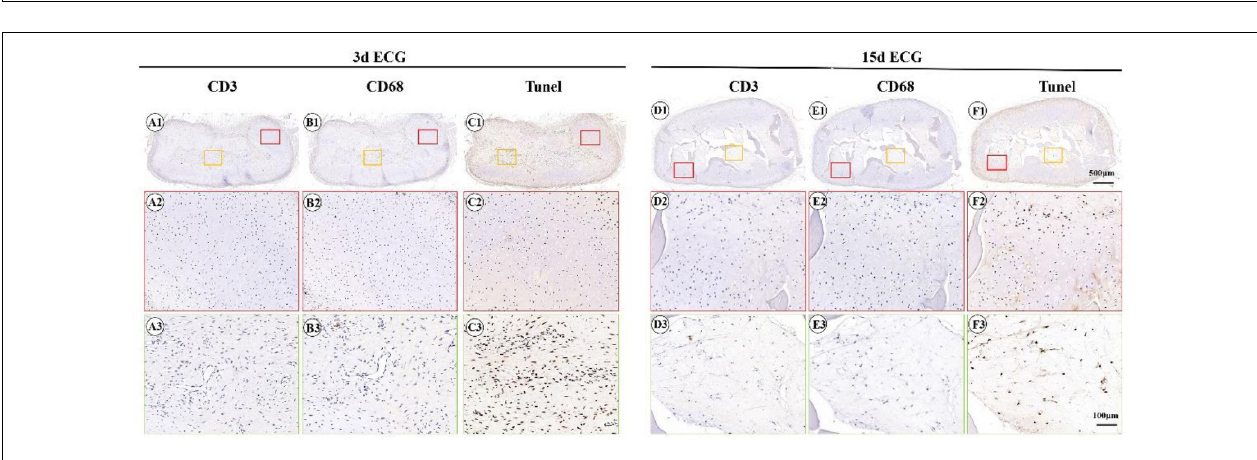
FIGURE 6 | Inflammatory reactions characterized by CD3, CD68, and terminal deoxynucleotidyl transferase biotin dUTP nick end labeling assay (TUNEL) staining. CD3 staining of 3 d engineered cartilage gel–decalcified bone matrix (ECG–DBM) (A1–A3) and 15 d ECG–DBM constructs (D1–D3) after 12 weeks in vivo in autologous goat. CD68 staining of 3 d ECG–DBM (B1–B3) and 15 d ECG–DBM (E1–E3) constructs after 12 weeks in vivo in autologous goat. TUNEL staining of 3 d ECG–DBM (C1–C3) and 15 d ECG–DBM (F1–F3) constructs after 12 weeks in vivo in autologous goat. The red box represents the mature cartilage-like tissue areas, and the orange box represents immature cartilage-like